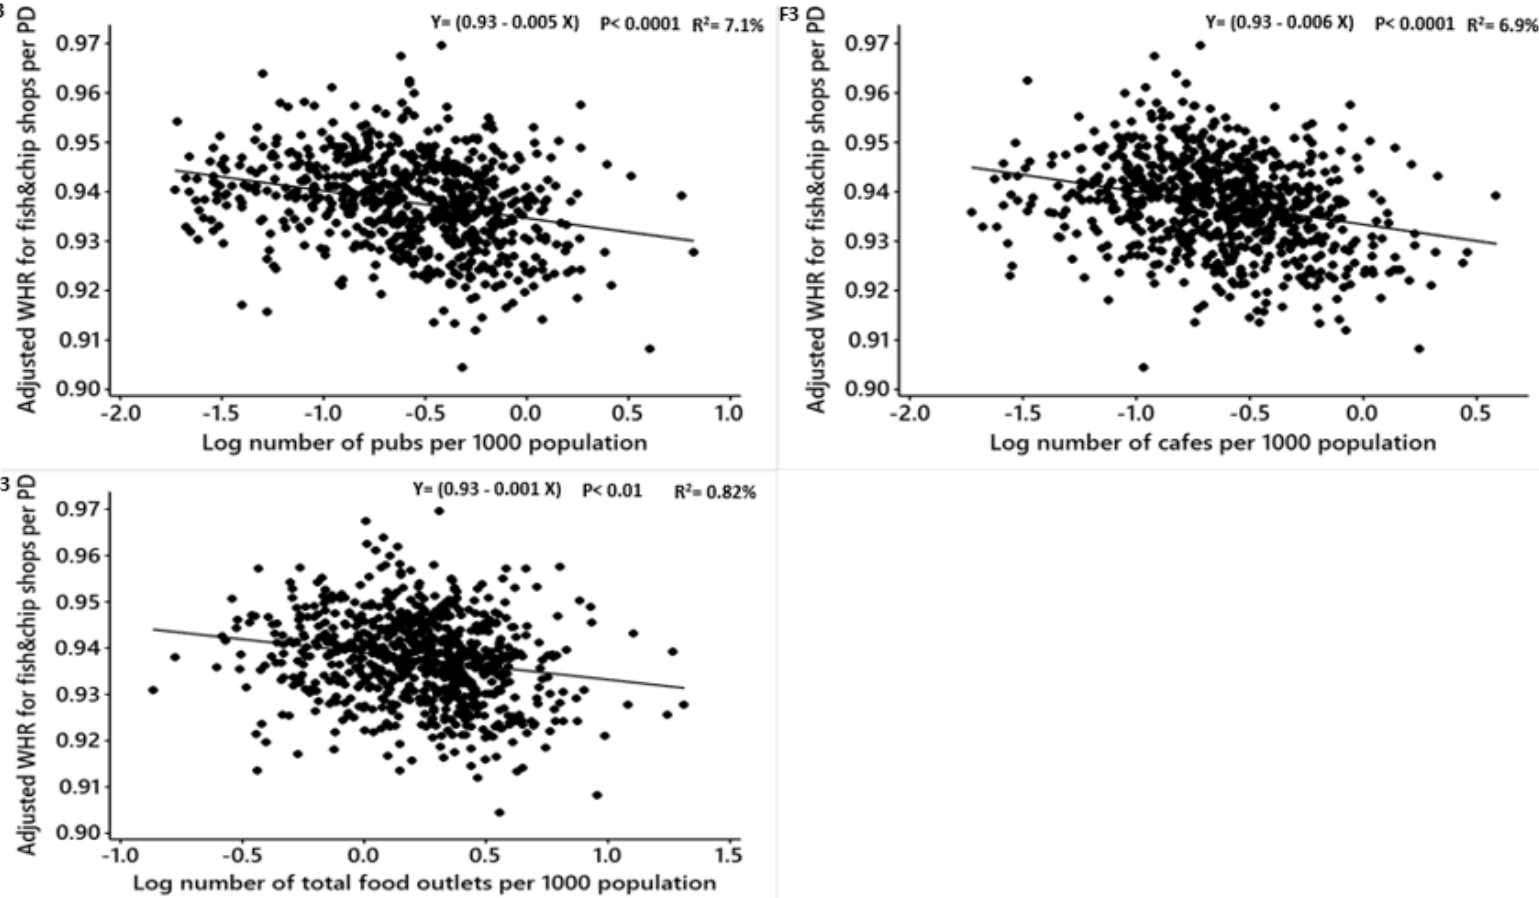
Figure 5. Males: Linear regression analysis of the association between log-transformed numbers of food outlets per 1000 population and adjusted obesity measures. Obesity measures adjusted for deprivation level per household, education, employment, ethnicity, household size, household income, age and density of fish and chip shops. BMI = Body Mass Index, WHR = Waist to Hip Ratio. FFR = Fast-Food Restaurants, FSR = Full-Service Restaurants, total food outlets =